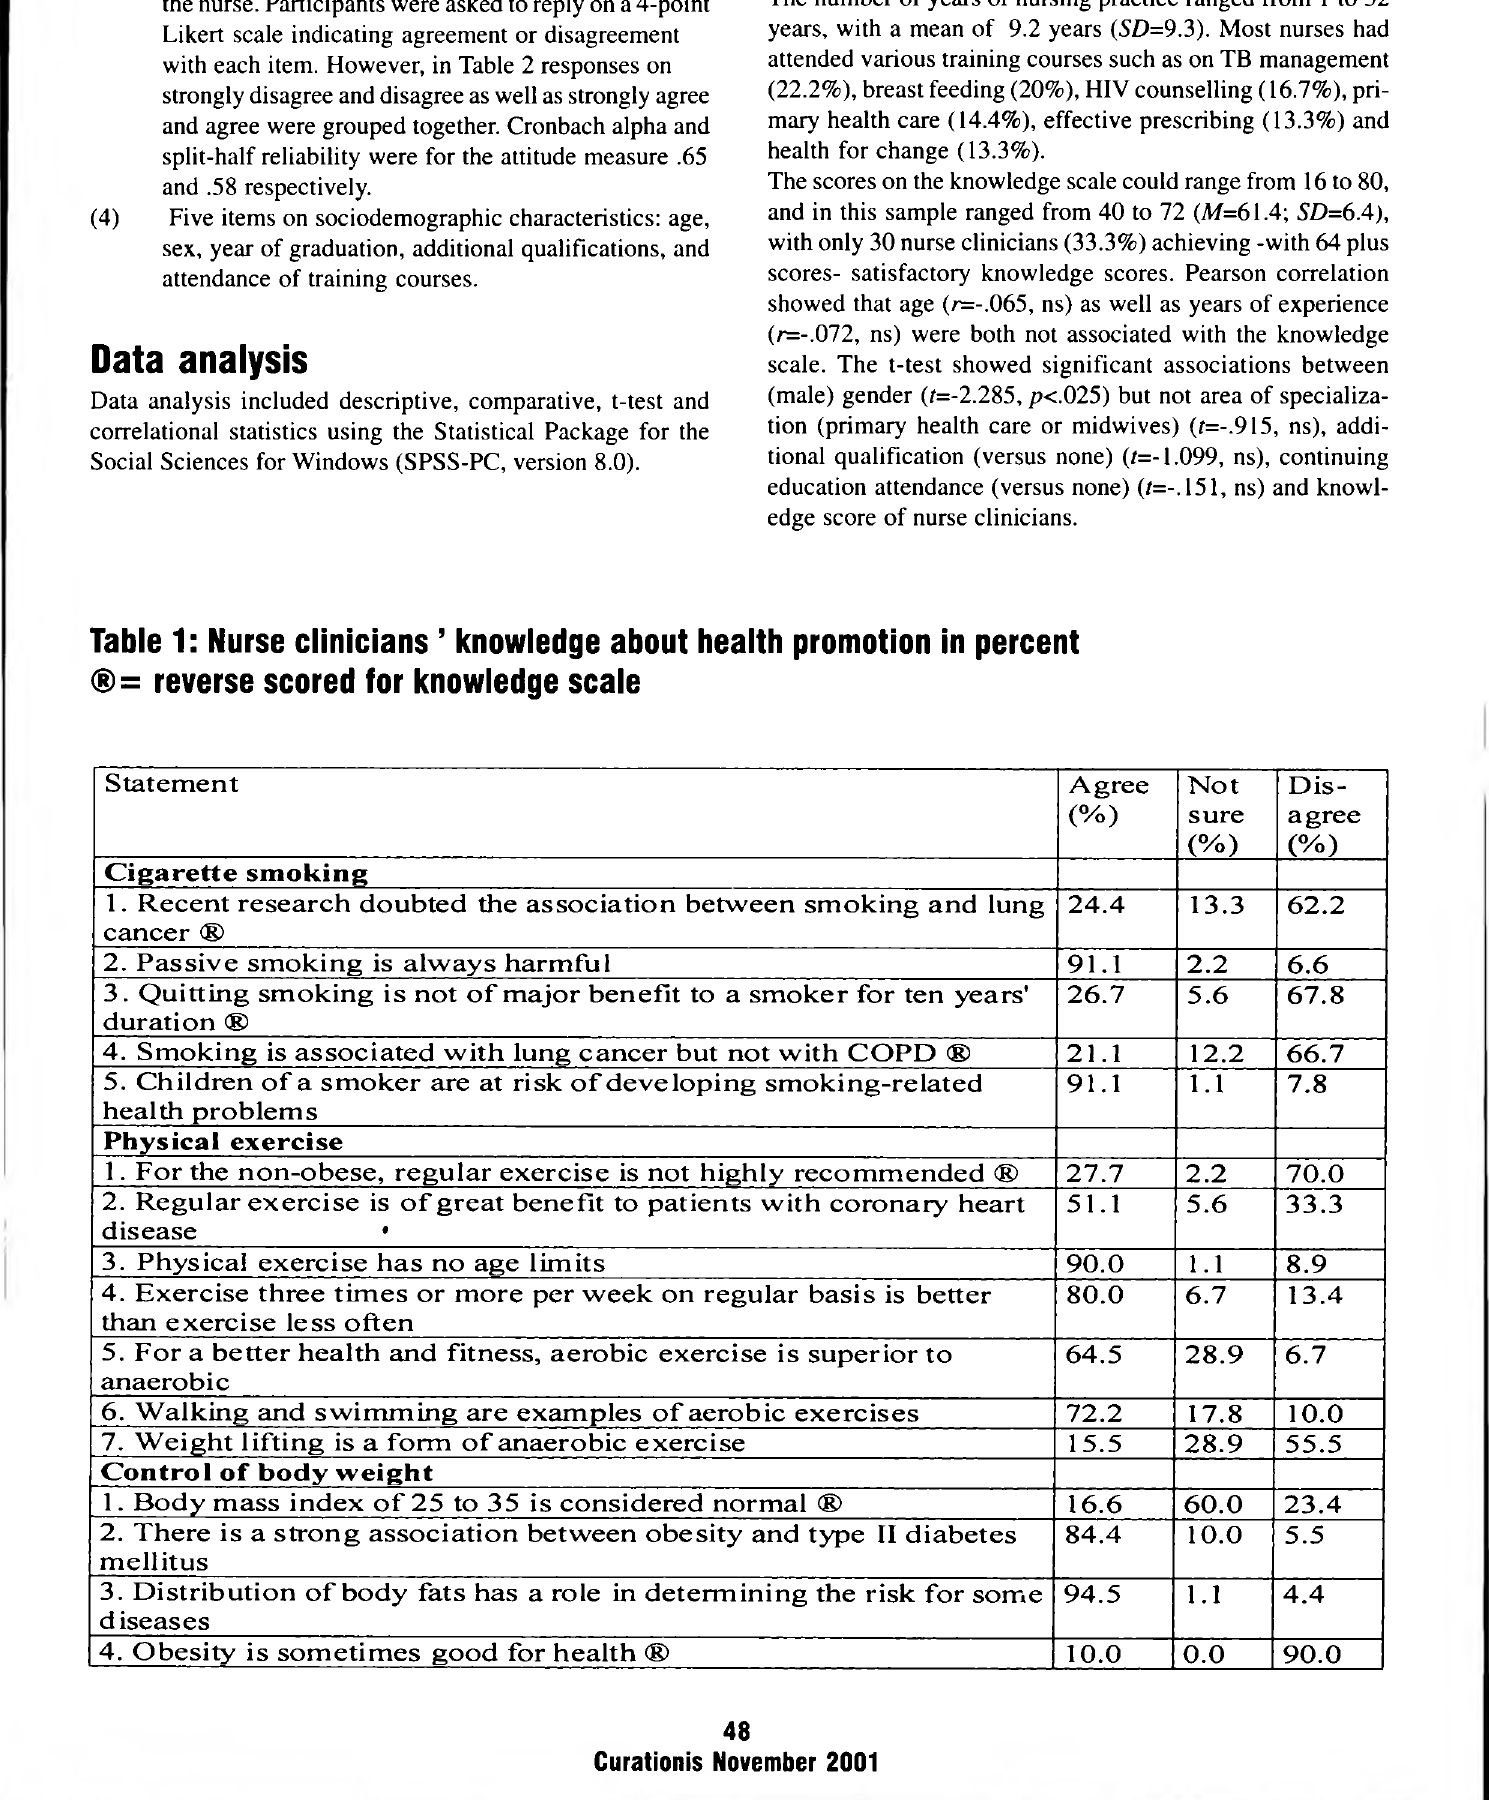
Table 1 : Nurse clinicians ’ knowledge about health promotion in percent ® = reverse scored for knowledge scale